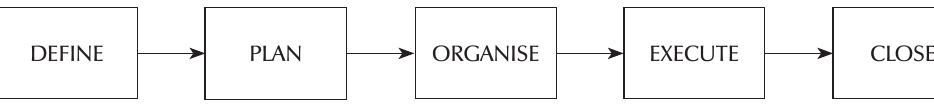
Generalized project management sequence (Openlearn, 2009)